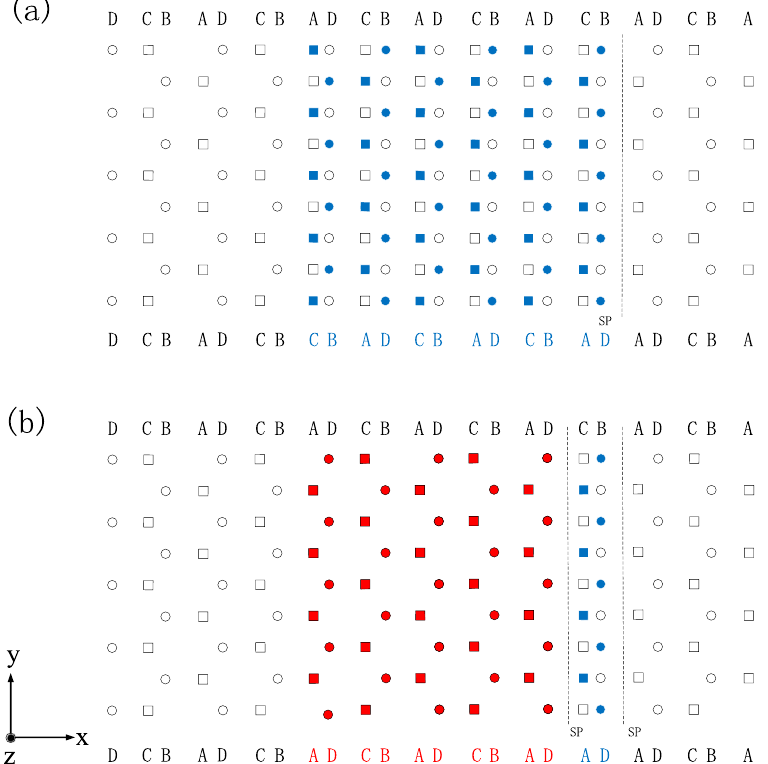
Figure 1. Atomic positions of HCP Ti after ( a ) the first and ( b ) the second slips of Shockley partial dislocation < > , the y axis is along 1210 < > and 110 < > of 1/6 1210 < > on 1010 { } planes. The x axis is along 1010 fcc hcp hcp < > . The hollow square and circular symbols < > and 001 and < > 110 , and the z axis is along 0001 fcc fcc hcp represent atoms on 0001 { } and 0002 { } planes, respectively. The filled blue and red symbols are atoms after the first and second slips of Shockley partial dislocation, respectively, and SP stands for the slip